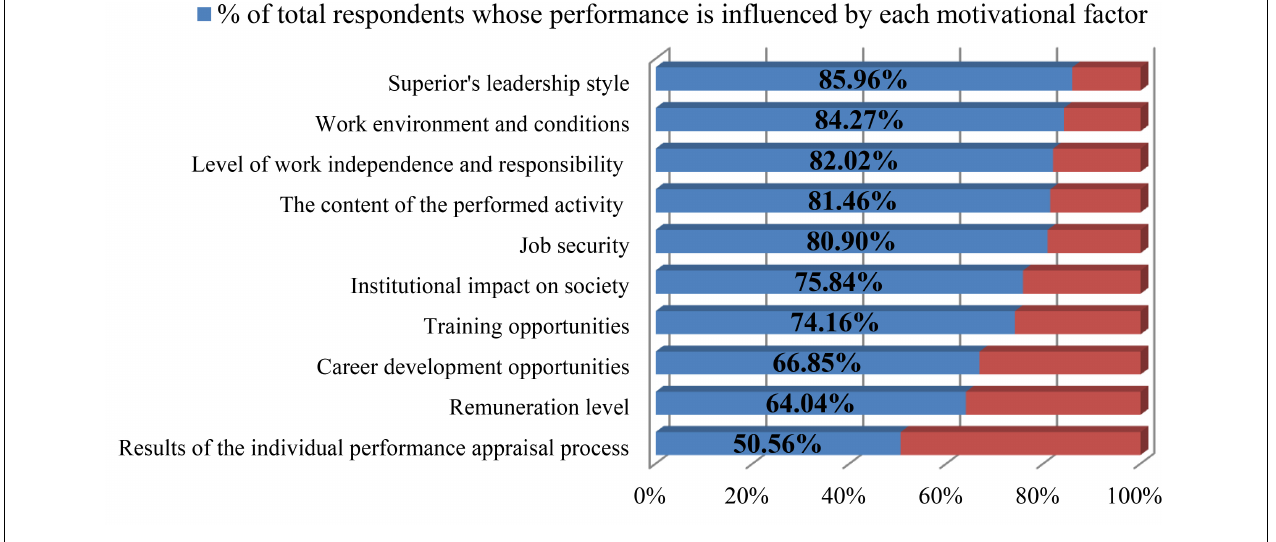
FIGURE 1 | Motivational factors that influence civil servants’ performance in the workplace. Source: Adapted after Ciobanu and Androniceanu